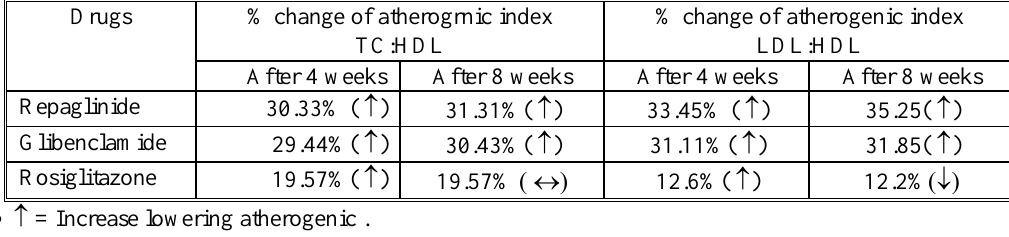
Table 5 : Percentage changes of atherogenic index TC : HDL and LDL :HDL in groups 1,2 and 3 of diabetic patients after 4 and 8 week of